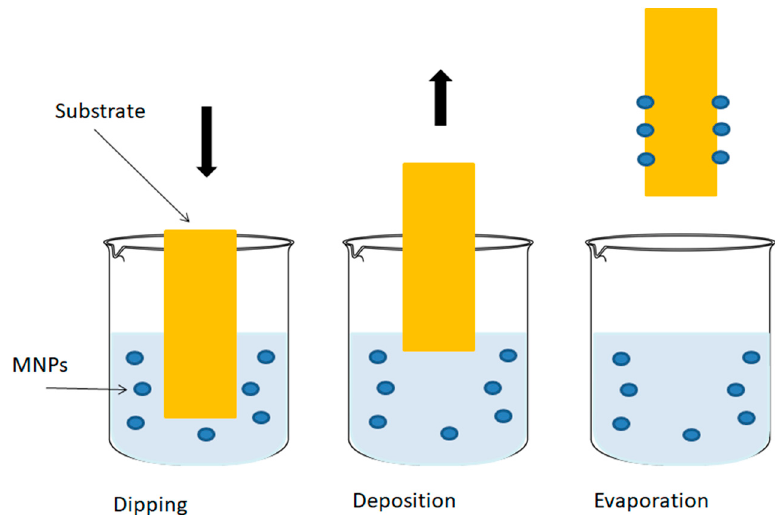
Figure 5. Schematic of the dip coating process showing the dipping, deposition of MNPs and evaporation to create the protein or polysaccharide magnetic material that can be used in biomedical applications.